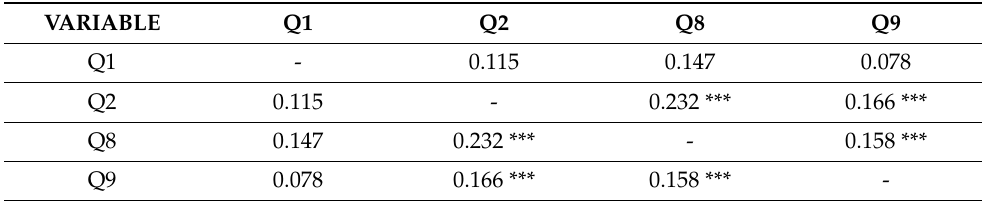
Table 5. Contingency coefficients (Pearson’s coefficient) for using environmental criteria in everyday life, awareness of SRI, and pro-ecological decisions vs. buying ecological products. VARIABLE Q1 Q2 Q8 Q9 Q1